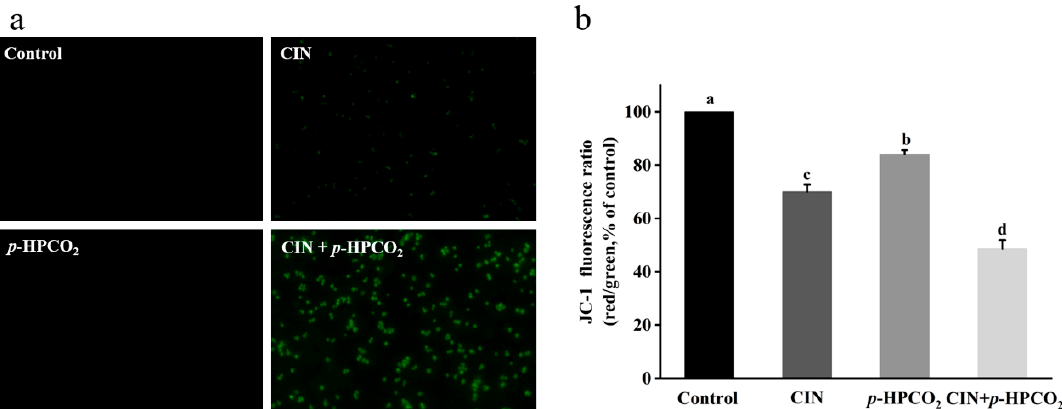
Figure 8. Fluorescent microscopic images of Saccharomyces cerevisiae cells stained with JC-1 (×400) ( a ) and relative red/green fluorescence intensity of JC-1 in S. cerevisiae ( b ). S. cerevisiae cells were treated with individual and combined cinnamon oil (CIN) (0.02%) and petit -high pressure CO 2 ( p -HPCO 2 ) (1.3 MPa) for 2 h at 25 °C, respectively. Different letters above bars mean significant differences ( p < 0.05).